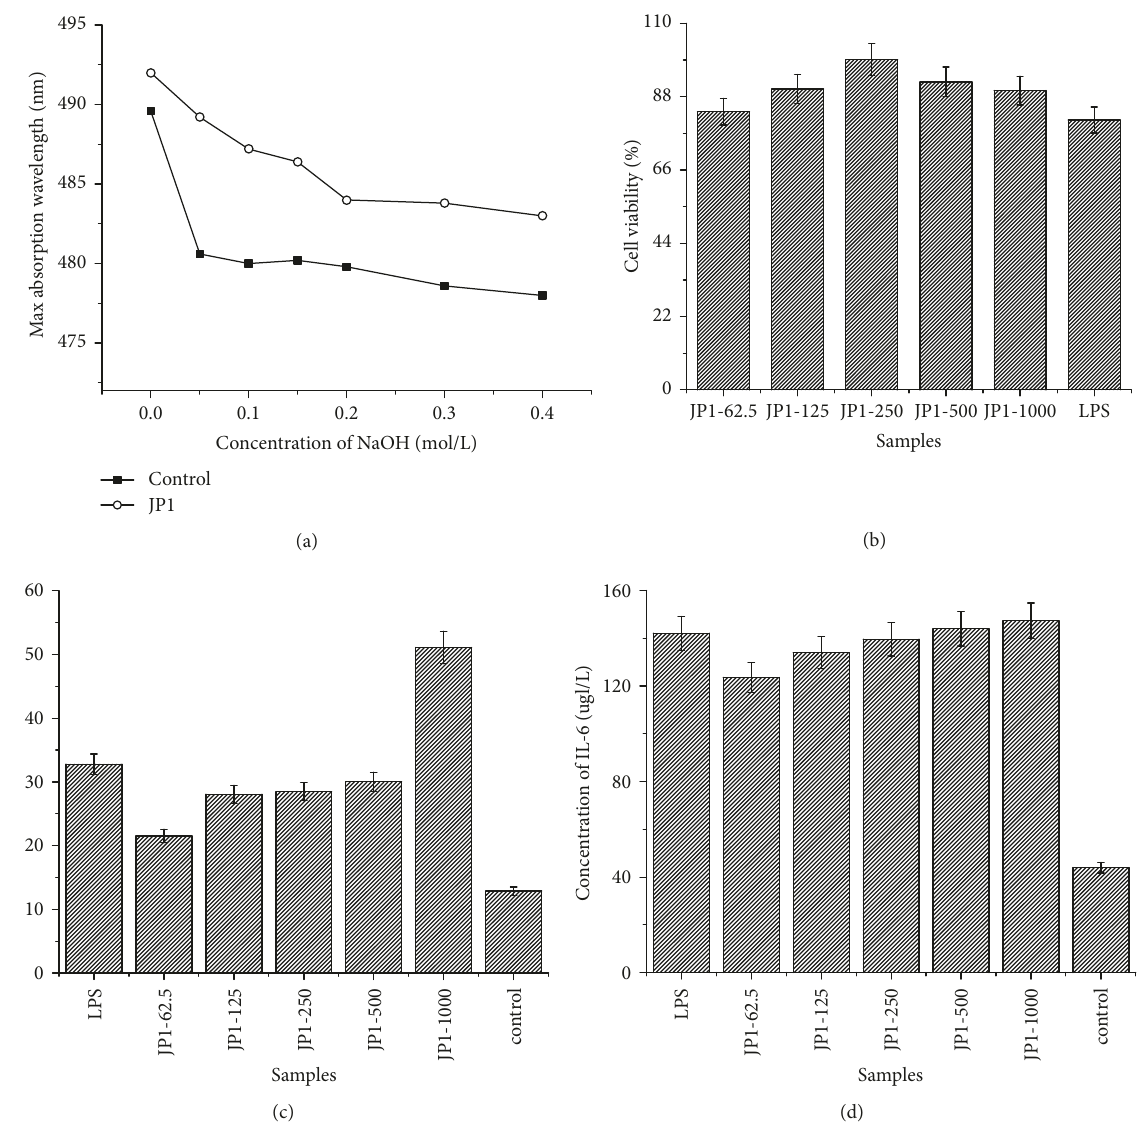
Figure 5: Congo Red test curve of JP1 (a) and its effect on cell viability (b), NO activity (c), and IL-6 (d) in RAW264.7 cells.